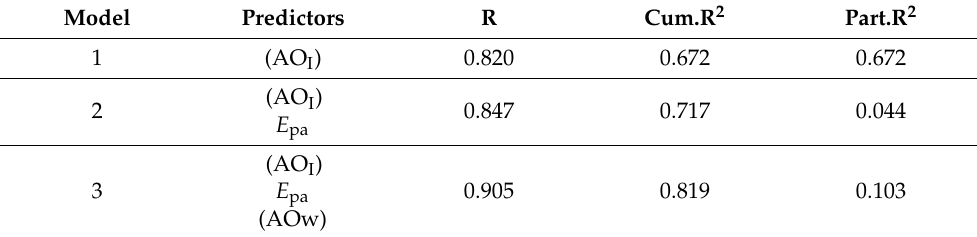
Table 3. Cumulative (Cum) R 2 , adjusted (Adj.) R 2 and partial (Part) R 2 in the stepwise linear regression